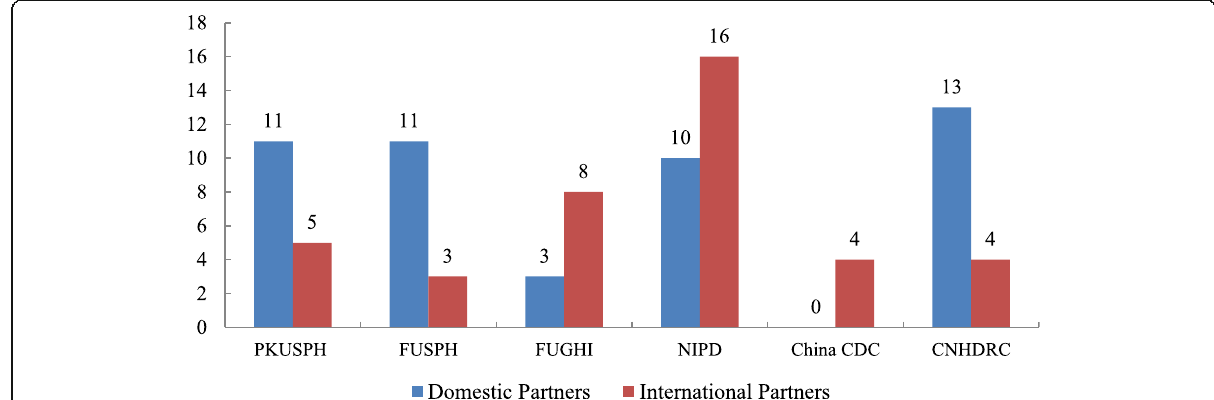
Fig. 7 Partnerships established with six Centers of Excellence under the GHSP. Data source: The GHSP project completion report from PMO, Mar